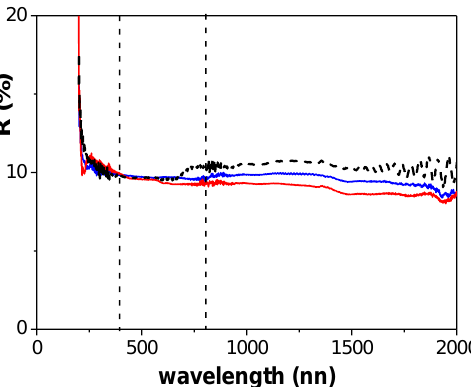
Figure 6. Light reflection as a function of wavelength for the RC/BMIMPF 6 film (red solid line), the RC/AliquatCl film (blue solid line) and the RC-support (black dashed line). Visible region: between the two vertical dashed black lines.